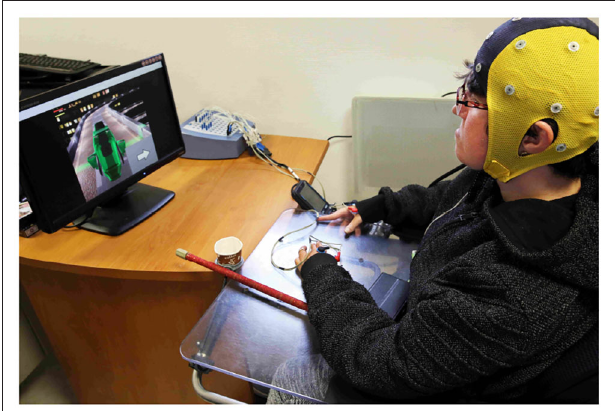
FIGURE 3 | Experimental setup of the MI-BCI system. The pilot is wearing the EEG cap and EMG electrodes are placed on her hands.